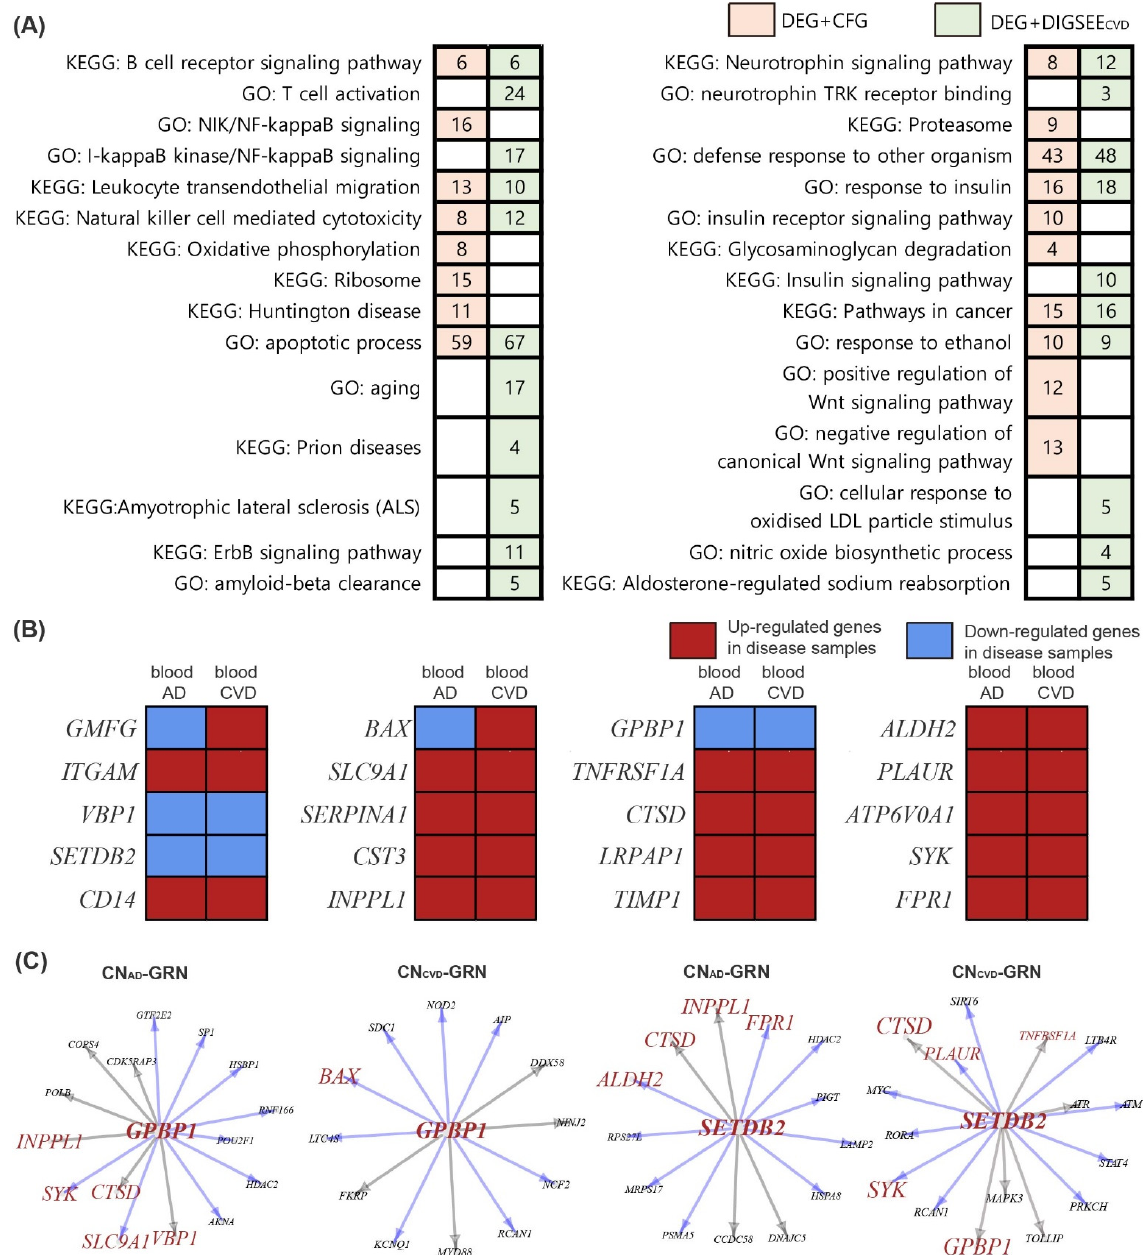
Figure 7. Biological functions and differential and regulatory patterns of the blood AD- (DEG + CFG) and CVD-related genes (DEG + DIGSEE CVD ). ( A ) Enriched pathways in DEG + CFG and DEG + DIGSEE CVD genes. Numbers in the colored rectangles indicate the number of the common genes between the DRGs and genes in each biological pathway. ( B ) Common genes between the DEG + CFG and DEG + DIGSEE CVD genes. The blood AD and CVD datasets are the integrated datasets obtained from three blood AD (GSE63061, GSE63060, and ROSMAP) and three blood CVD datasets (GSE60993, GSE20681, and GSE59867), respectively. ( C ) Transcription factors GPBP1 and SETDB2 have decreased edges with child genes in both AD and CVD networks. Brown-colored genes indicate the common genes between DEG + CFG and DEG + DIGSEE CVD . Blue arrows indicate the edges that disappear in the disease GRN. Grey arrows denote the edges that are simultaneously present in the disease and CN GRNs. AD, Alzheimer’s disease; CVD, cardiovascular disease; CN, control; DEG, differentially expressed gene; CFG, convergent functional genomics; GO, gene ontology; KEGG, Kyoto Encyclopedia of Genes and Genomes; GRN, gene regulatory network.